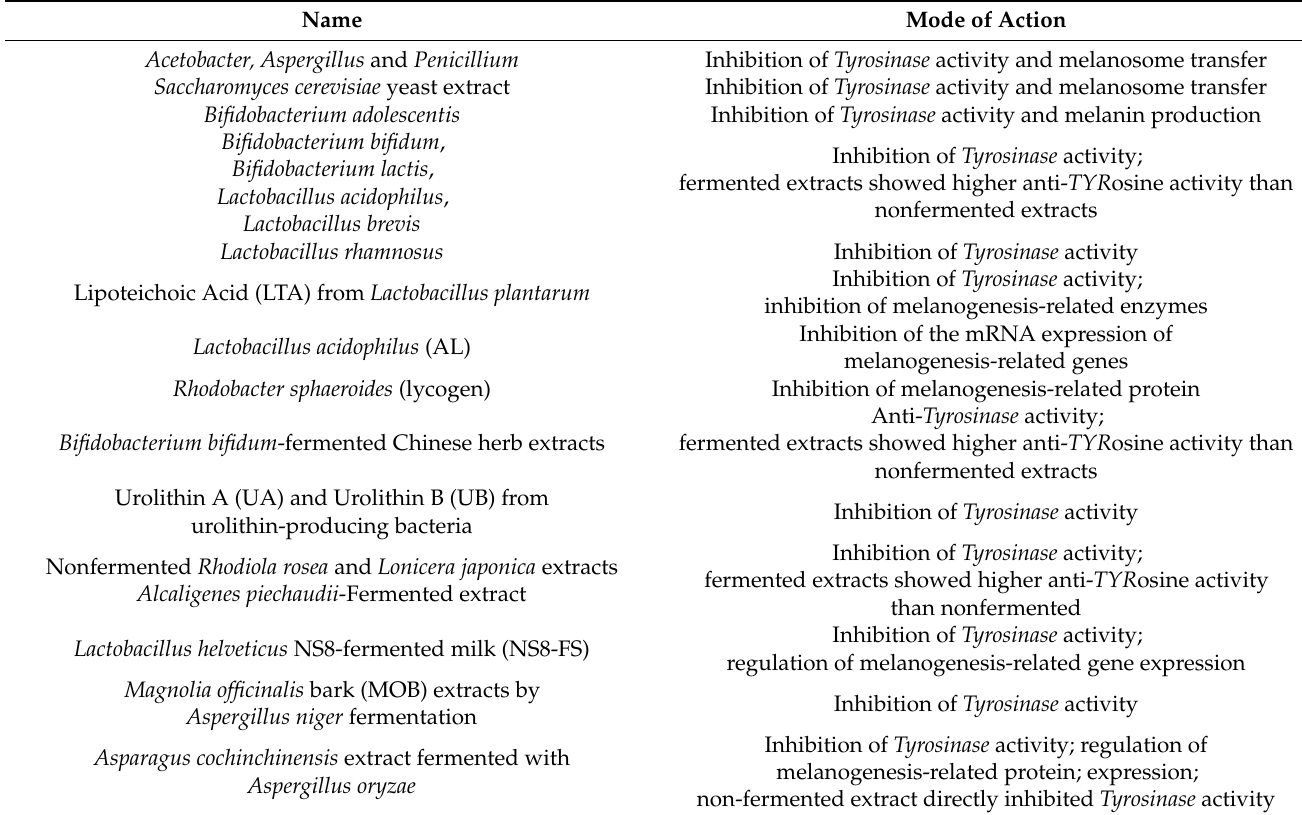
Table 3. List of skin-whitening agents derived from bacteria or